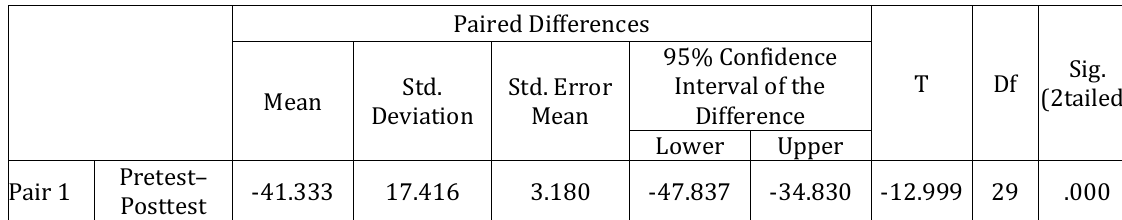
Table 4.7 the paired sample test of pre-test and